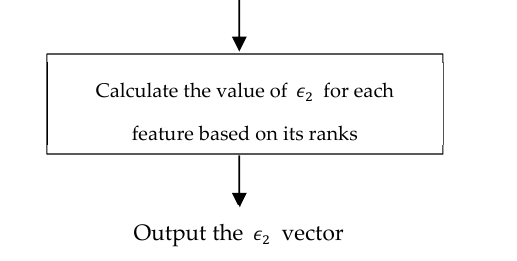
Figure 1. Flowchart of the ensemble of feature rankers to calculate the (cid:2035) (cid:2870) vector.